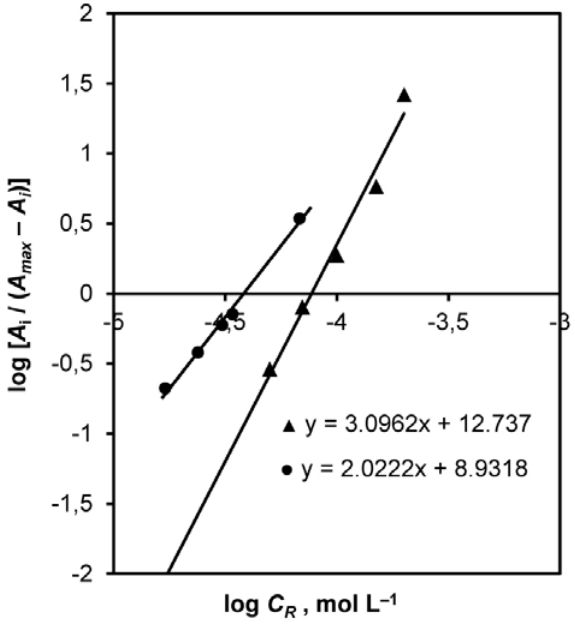
Figure 4. Straight lines by the mobile equilibrium method for de- termination of the molar ratios Ge(IV):4-NC and Ge(IV):Nt; = 2.0 × 10 –5 mol L –1 ; pH = 4.0; λ = 405 nm; τ = 2 min (cid:2) C Ge(IV) Ge(IV) : 4-NC, C = 1.7 × 10 –4 mol L –1 ; (cid:2) Ge(IV) : Nt, C Nt × 10 –4 mol L –1